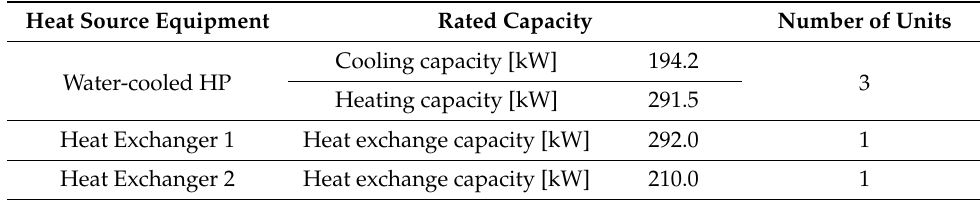
Table 3. The rated capacity of the heat source equipment.